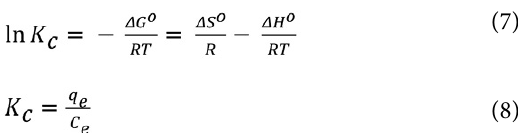
Table 1. Langmuir and Freundlich isotherm parameters for the ad- sorption of DR-28 and DB-22 (pH: original, adsorbent: KZF,